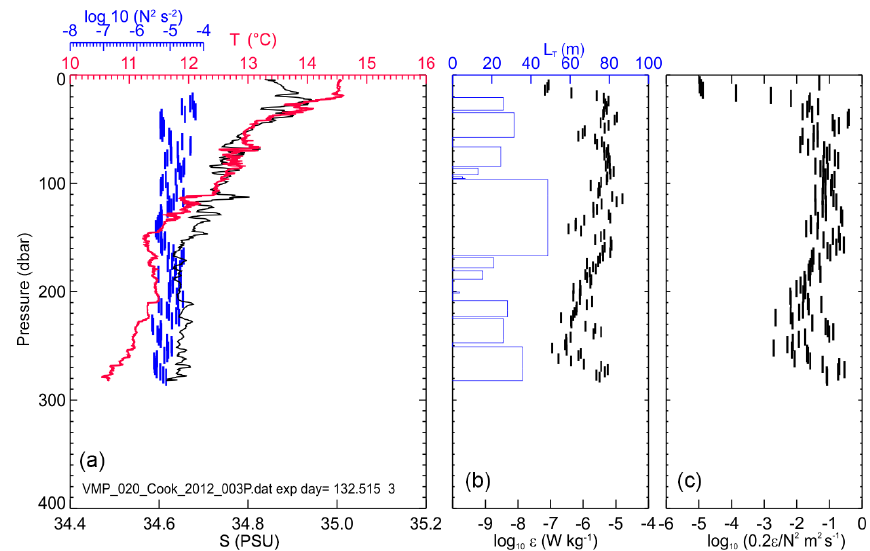
Figure 7. Profile A from day 132, 2012, showing (a) temperature, salinity and buoyancy frequency squared ( N 2 ); (b) L T and ε ; and (c) proxy for vertical diffusivity 0.2 ε/N 2 . Note the profile extends over the full depth of the water column.